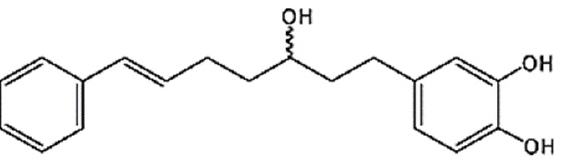
Figure 1. Structure of ASPP 092 [7-(3,4-dihydroxy-phenyl)-5-hydroxy-1-phenyl-(1E)-1-hepten]; molecular weight: 298.38.